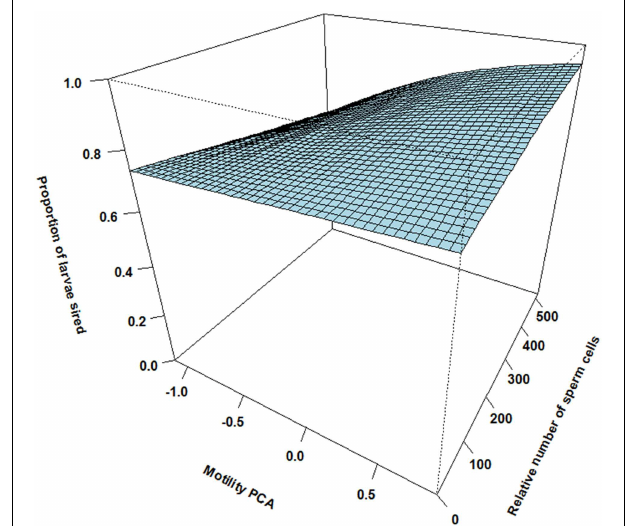
FIGURE 3 | The effect of relative motility PCA (i.e., per cent motile sperm cells and sperm velocity in water and ovarian fluid) and the relative number of sperm cells on proportion of larvae sired for dominant males ejaculating before the competing subordinate male (asynchrony). Although dominant males show a sharp increase in paternity with increasing sperm motility PCA independent of sperm numbers, dominants show low sperm velocity compared to subordinates under natural reproduction.